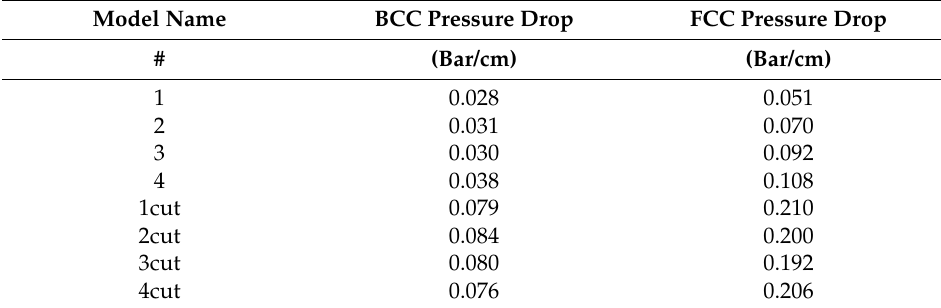
Table 1. Pressure drops of 8 models for BCC and FCC model for water at 20 ◦ C flowing with 1 m/s velocity.